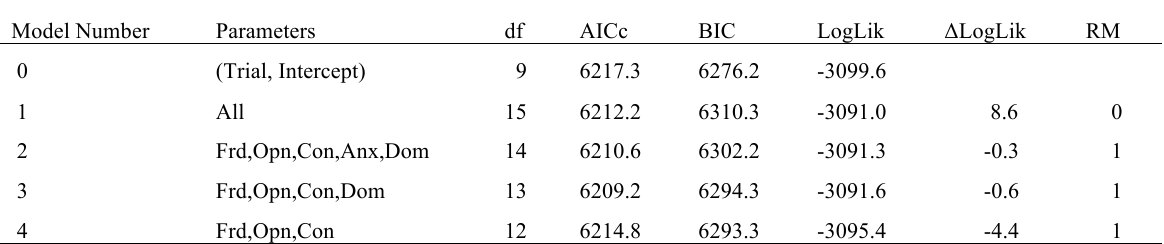
Model Selection Results for Regressions Predicting Log Transformed Rts on Only Correct Trials Model